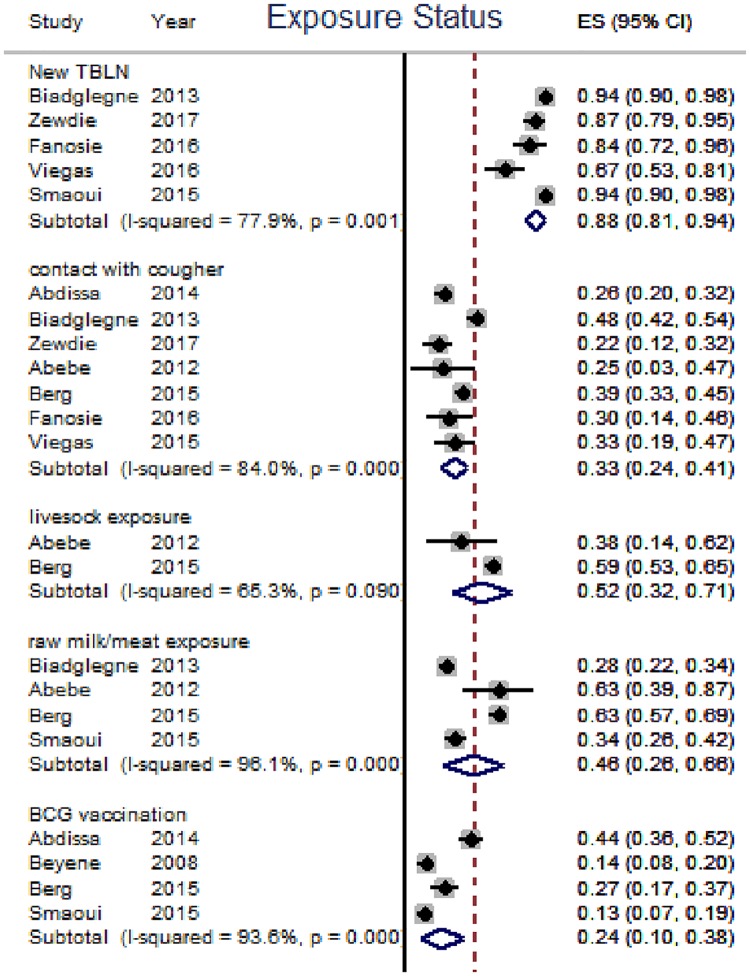
Prevalence of key exposure variables among TBLN cases, Africa, 1970–2015.